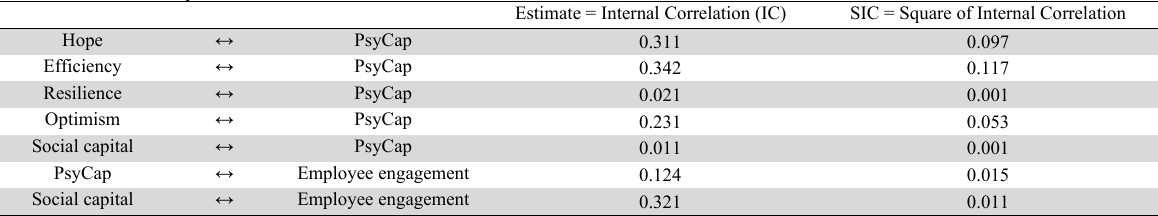
Discriminant Validity